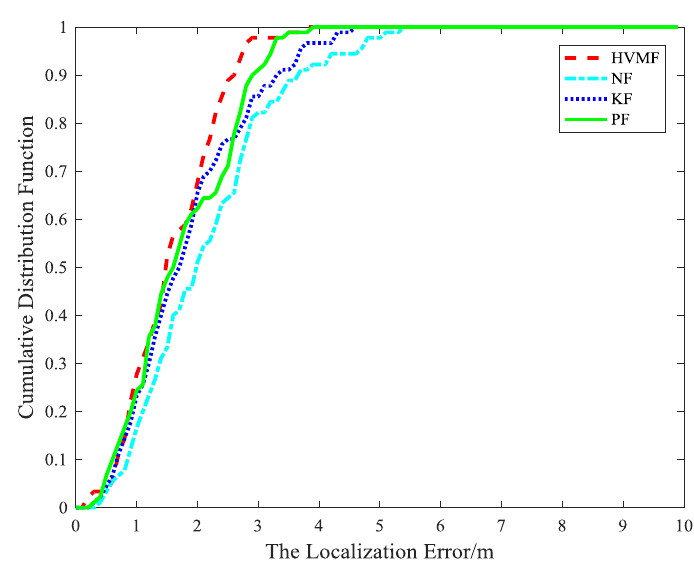
Figure 9. The localization error versus CDF.